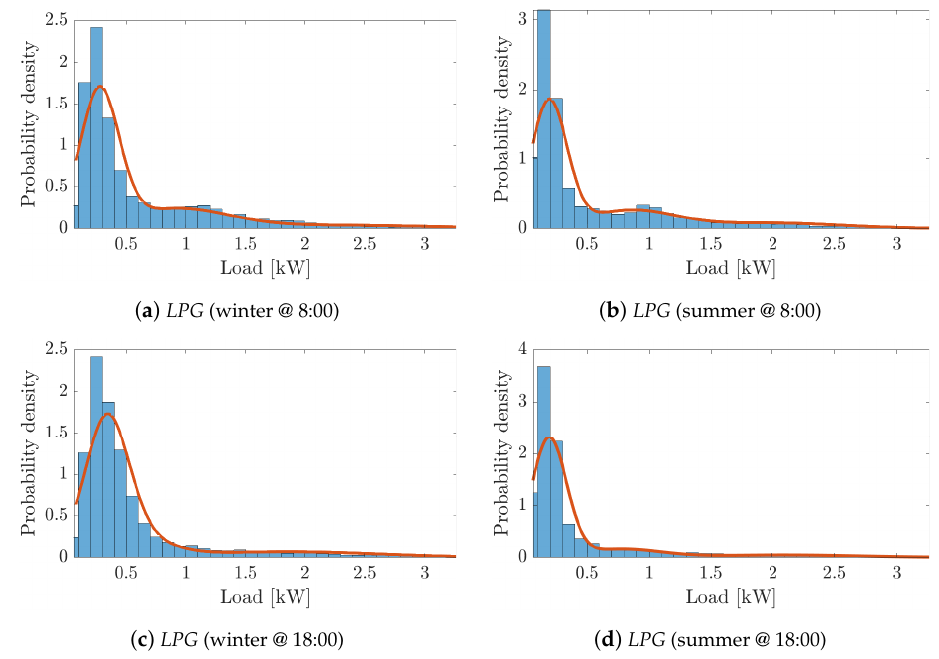
Figure 4. Histograms of the LPG original LPs and PDFs of the corresponding SLPs (solid lines) at two different times of the day (8:00 and 18:00) in winter and summer, respectively. Histograms computation and GMM PDFs fitting are performed using the same amount of data and refer to the most populated